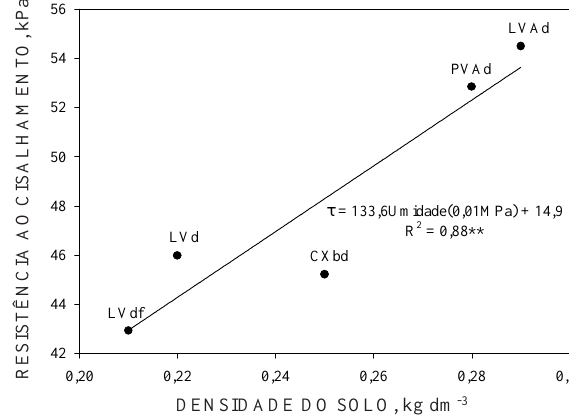
Figura 4. Variação da resistência ao cisalhamento dos solos com a umidade dos